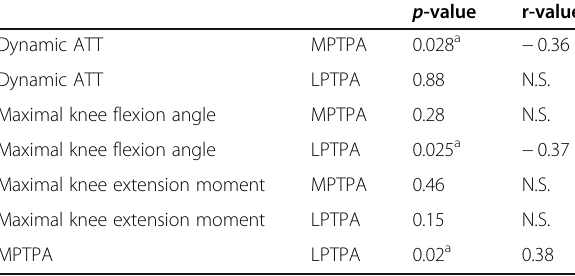
Table 2 correlations between the tibia plateau angels and dynamic ATT, maximal knee flexion angles and maximal